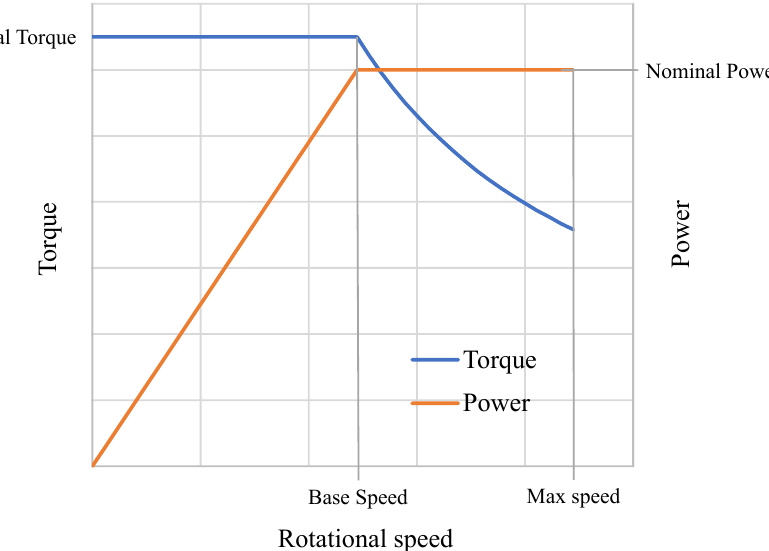
Figure 8. Typical torque–speed and power–speed profiles of the electric machines considered in this